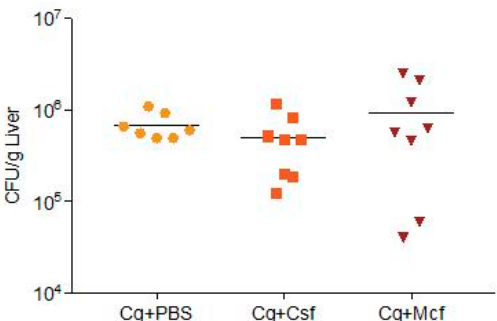
Figure 1. Liver fungal burden of CD1 mice 72 h after intravenously challenged with 1 × 10 8 biofilm cells plus two cycles of treatment with PBS, caspofungin (Csf), or micafungin (Mcf). Data are representative of two independent experiments. Each symbol represents an individual mouse, and horizontal bars are means of colony forming unit (CFU) numbers for each group. The obtained results are displayed as CFU/liver. Controls (naïve; PBS + Csf; PBS + Mcf), n = 2; Cg + Csf, n = 8; Cg + Mcf, n = 8. No statistical differences were observed among infected groups (evaluated by Kruskal–Wallis (Overall ANOVA P < 0.05) and post hoc Sidak’s multiple comparison tests). Cg— Candida glabrata ATCC2001.